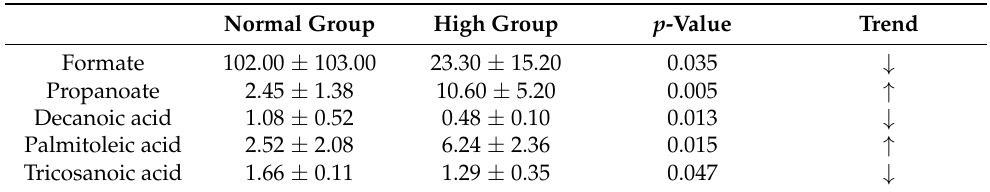
connection with normal and high intake of bamboo